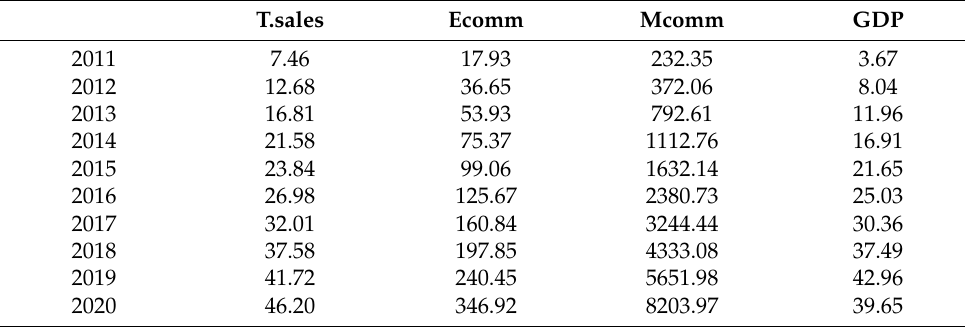
Table 3. The growth rates of variables that characterize sales and economic growth (%).